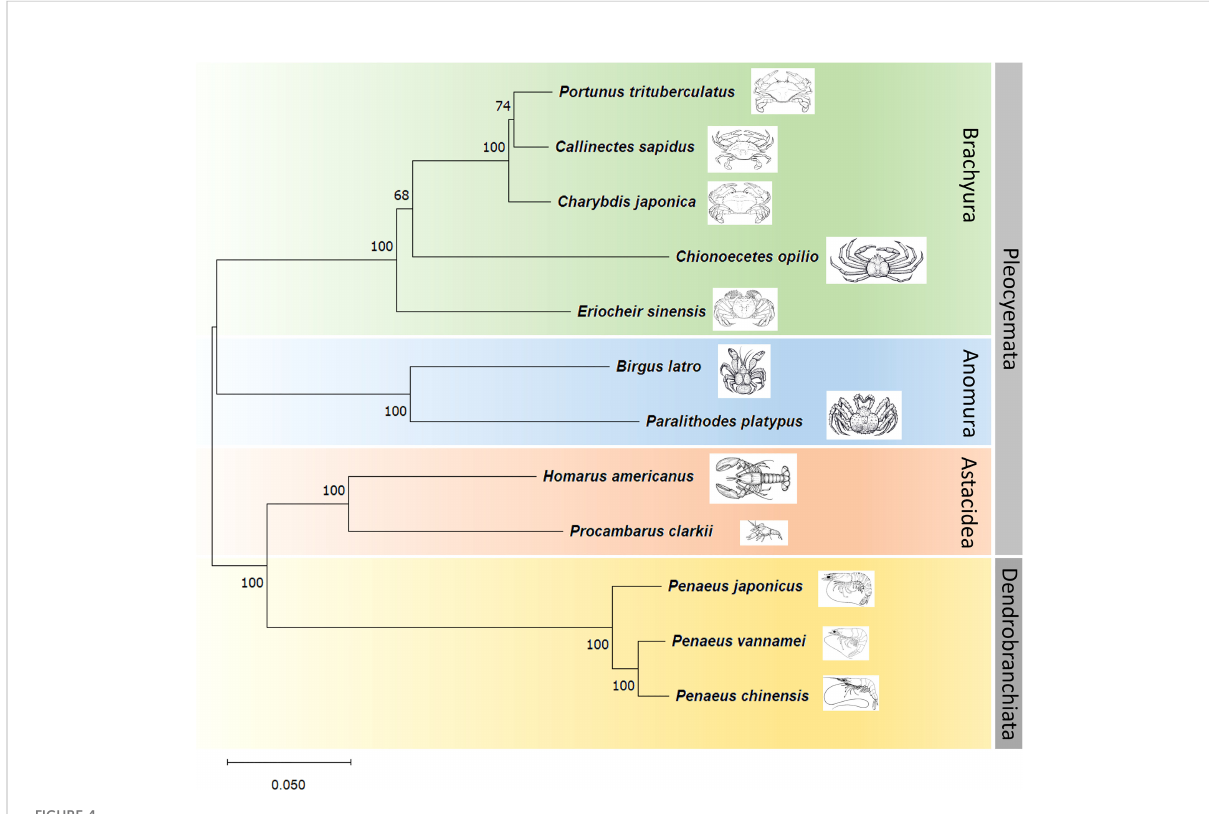
FIGURE 4 Neighbor-Joining tree based on the conserved ANK2 protein fragments of 12 Decapoda